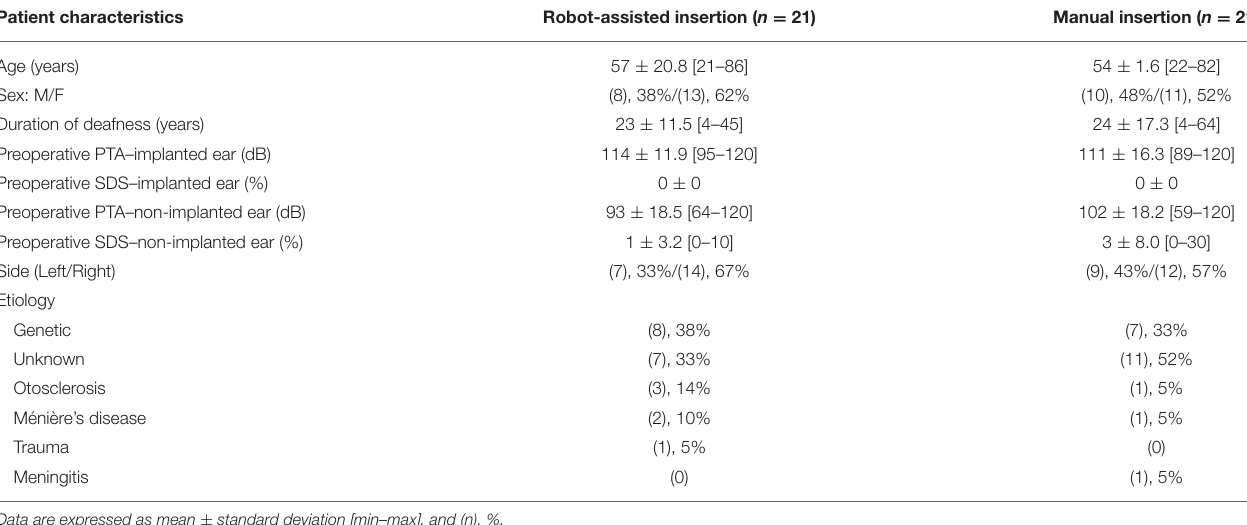
TABLE 1 | Clinical characteristics of the implanted patients.